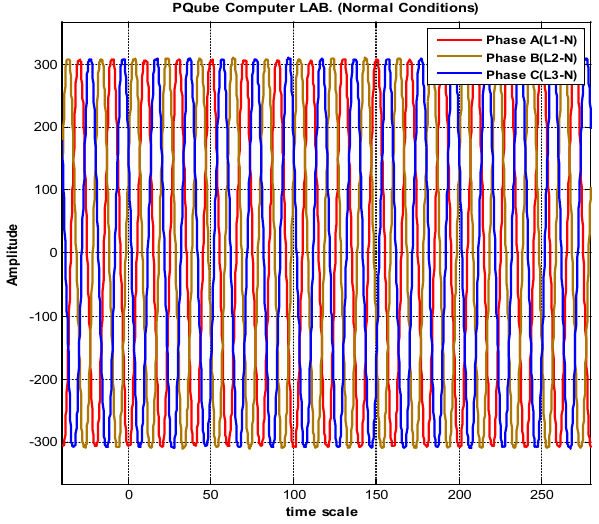
Fig. 7. After removing first imf normal condition of signal